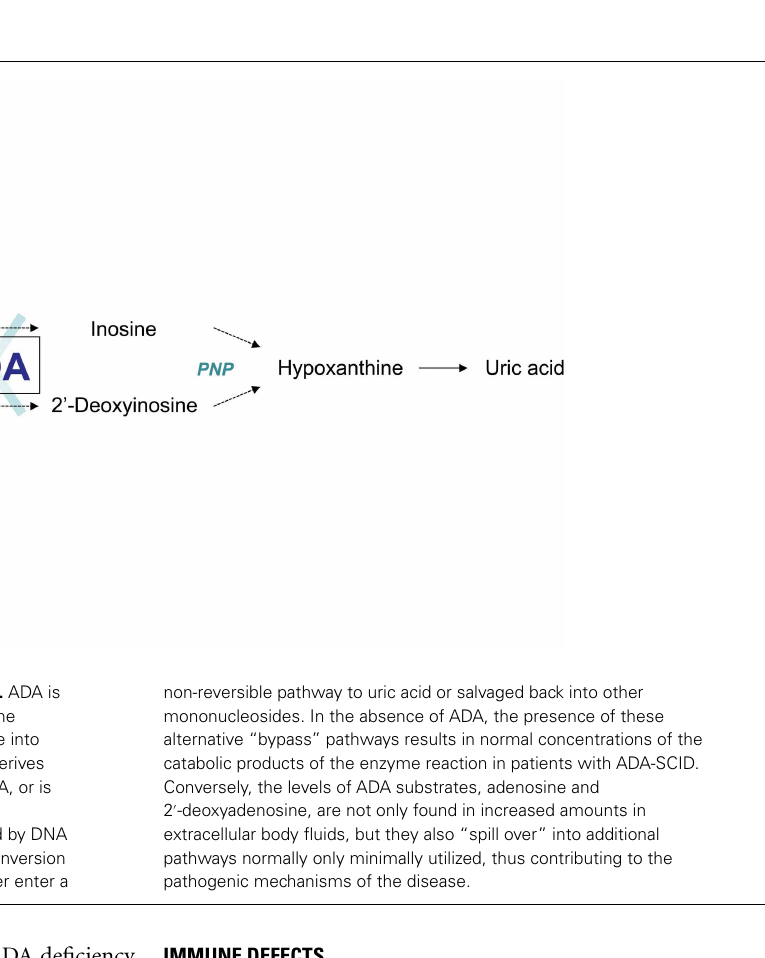
non-reversible pathway to uric acid or salvaged back into other mononucleosides. In the absence of ADA, the presence of these alternative “bypass” pathways results in normal concentrations of the catabolic products of the enzyme reaction in patients with ADA-SCID. Conversely, the levels of ADA substrates, adenosine and 2 (cid:48) -deoxyadenosine, are not only found in increased amounts in extracellular body fluids, but they also “spill over” into additional pathways normally only minimally utilized, thus contributing to the pathogenic mechanisms of the